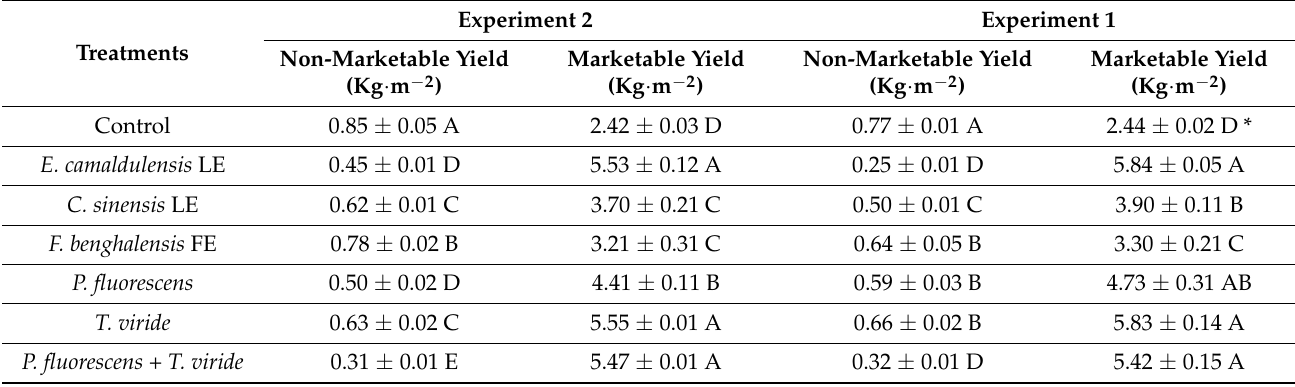
Table 5. Marketable yield and non-marketable yield (kg.m − 2 ) of zucchini as affected by natural plant extracts and microbial